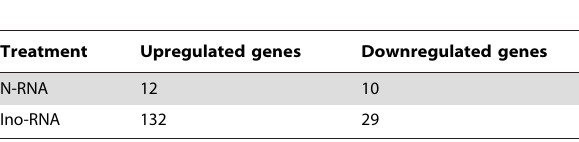
Table 1. Microarray analysis of RNA from PHBE cells treated with Ino-RNA.